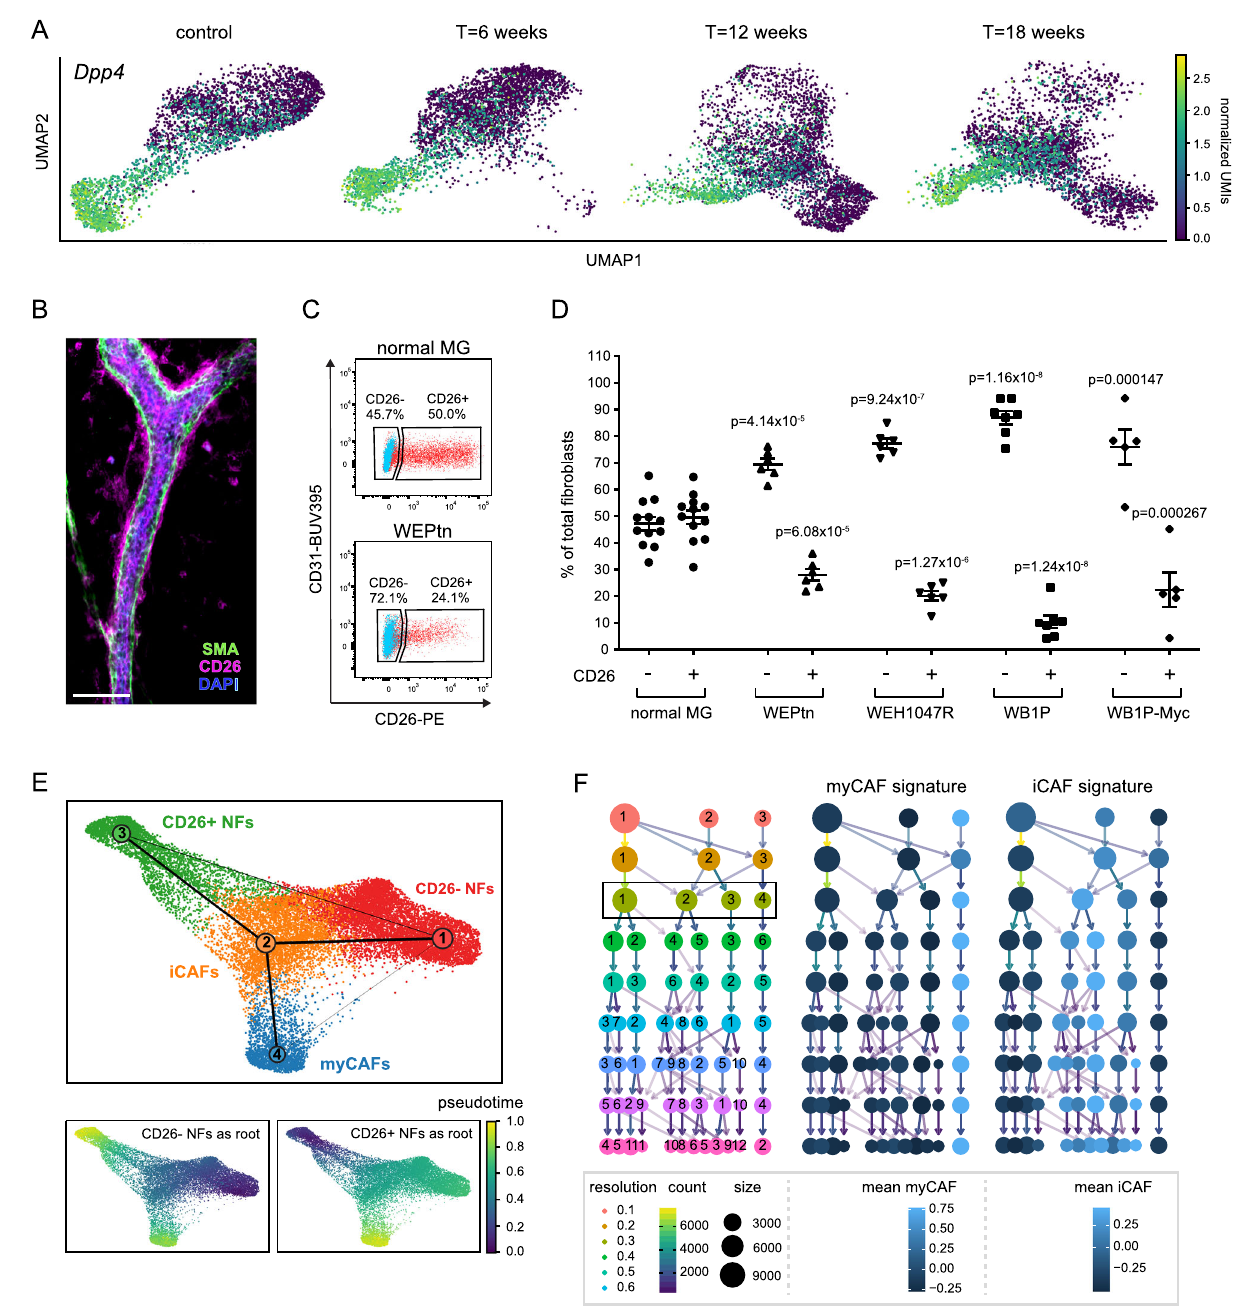
Fig. 5 | Ratio of CD26 − and CD26+ fi broblasts change during tumor develop- ment and both CD26 − and CD26+NFs contributeto CAF populations.A UMAP plot of single-cell transcriptomics data of NFs and CAFs isolated during mammary tumorigenesis in WEPtn mice (Fig. 3A) showing CD26 ( Dpp4 ) expression. B Whole mount analysis of normal mammary gland stained for CD26 (in magenta) and smooth muscle actin (SMA, in green) and dapi (in blue). Scale bar is 50um. Representative image is shown from two biological replicates with similar results. C FlowcytometryanalysisofnormalmammaryglandandWEPtn-derivedILCgated on fi broblasts (EpCAM − /CD45 − /CD31 − cells) shows the presence of CD26 − and CD26+ fi broblasts. Shown in blue is fl uorescence-minus-one (FMO) control and showninredisfullstainedsample.FMOcontrolwasusedtosetgates. D Percentage of CD26 − and CD26+ fi broblastsincontrolmammaryglands( n =12mice)and end- stagetumorsderivedfromWEPtn( n =6mice),WEH1047R( n =6mice),WB1P( n =7 mice)andWB1P-Mycmice( n =5mice).Atwo-wayANOVAwithBonferonnimultiple